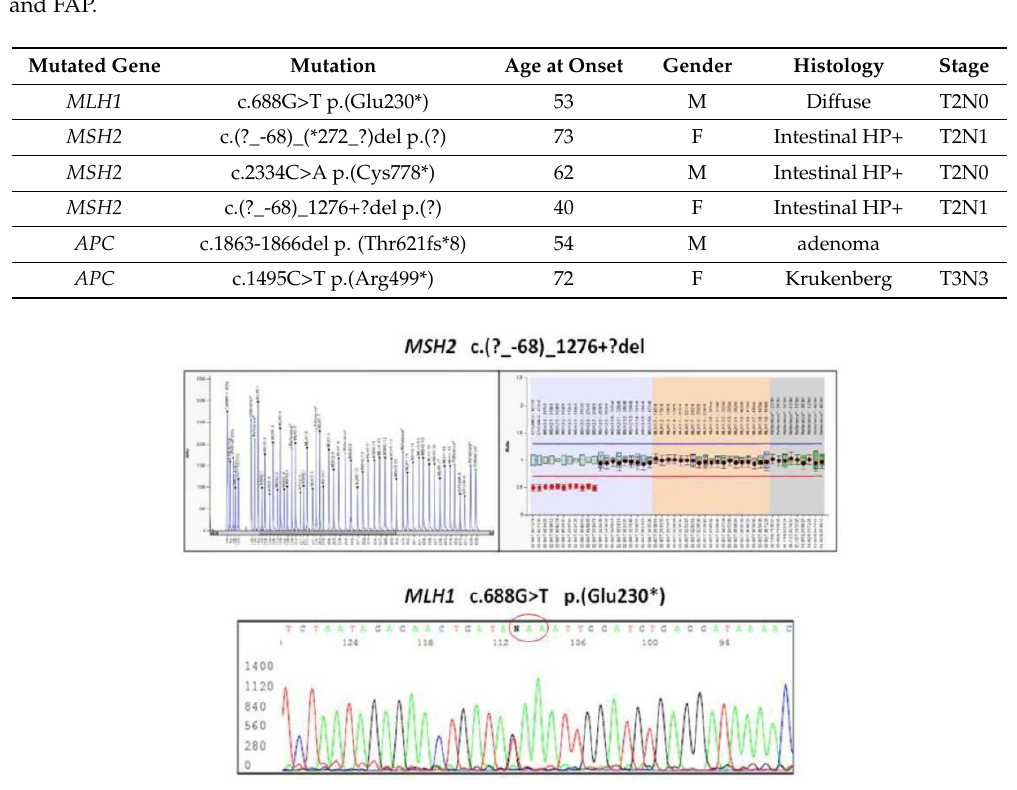
Figure 1. Representative mismatch repair gene mutations. Top panels: MLPA electropherogram ( left ) and analysis of MLPA data with the Software Coffalyser v.140721.1958 (MRC-Holland, Amsterdam, Holland). (NET ( right ) showing the MSH2 c.(?_-68)_1276+?del variant, corresponding to a large deletion encompassing exons 1–7. Bottom panel: Sanger sequencing showing the MLH1 c.688G>T variant producing the truncated p.(G1u230*) protein. The mutated codon (GAA > TAA) is circled in red.